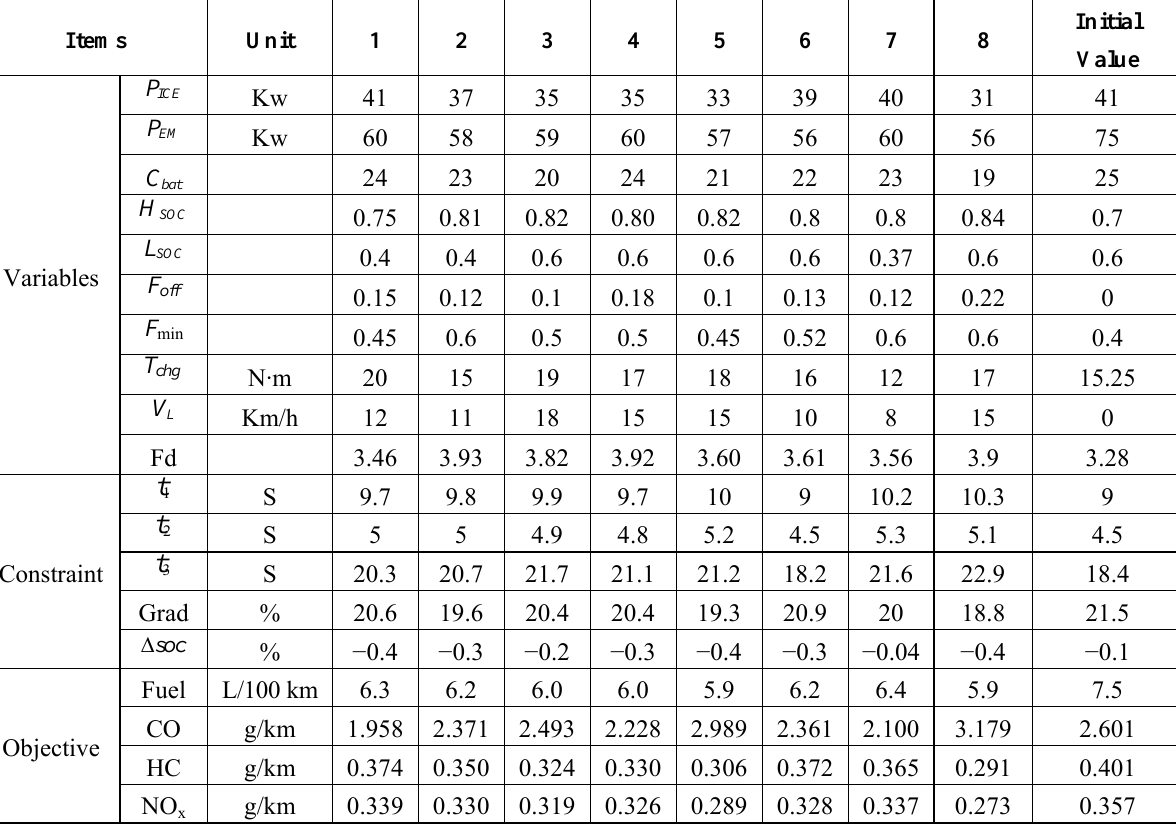
Table 4. Fuel consumption and emission of the HEV before and after the optimization.